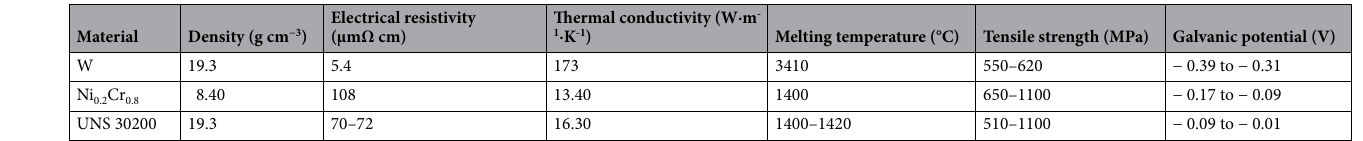
Table 1. Mechanical and electrical properties of materials used as corona